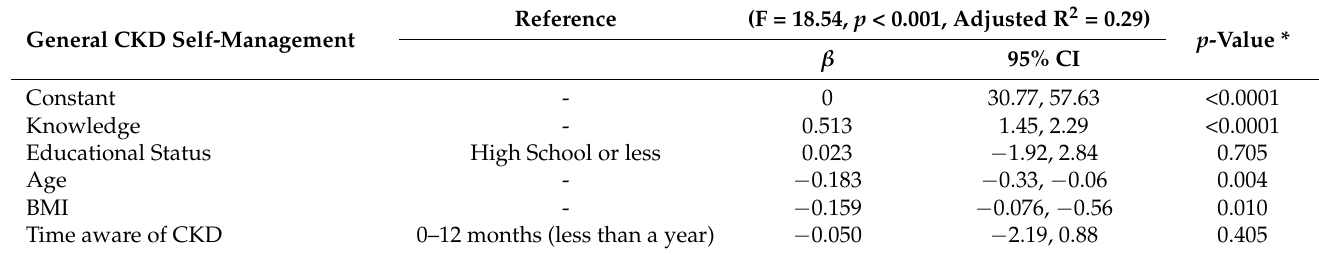
Table 3. Multiple regression analysis for variables predicting